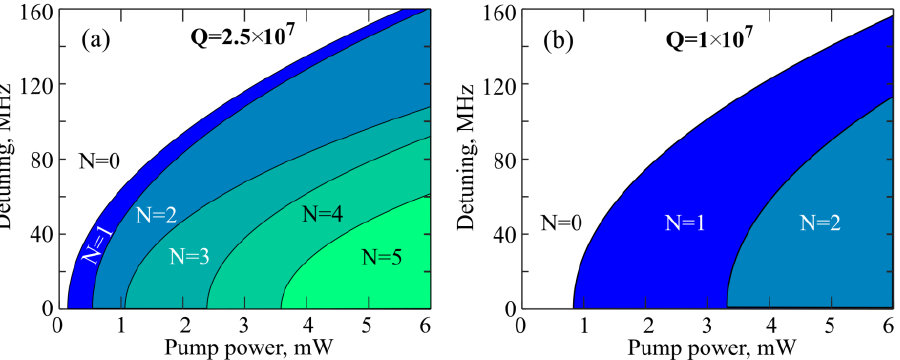
Figure 12. Theoretically calculated diagram demonstrating the number of Brillouin laser cascades for different pump powers and detuning for loaded Q-factors: Q = 2.5 × 10 7 ( a ) and Q = 1 × 10 7 ( b ).